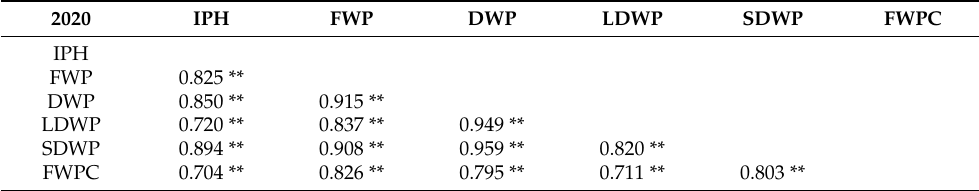
Table 3. Correlation coefficients among the 6 traits in the 302 ramie accessions